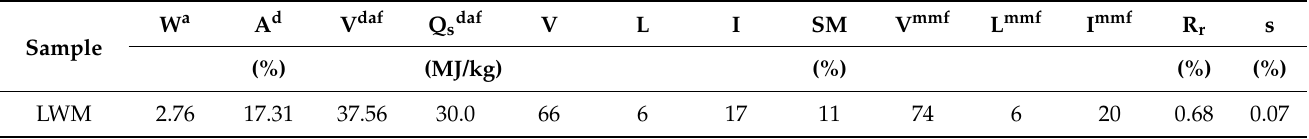
Table 2. Technological parameters and petrographic composition of a coal sample.